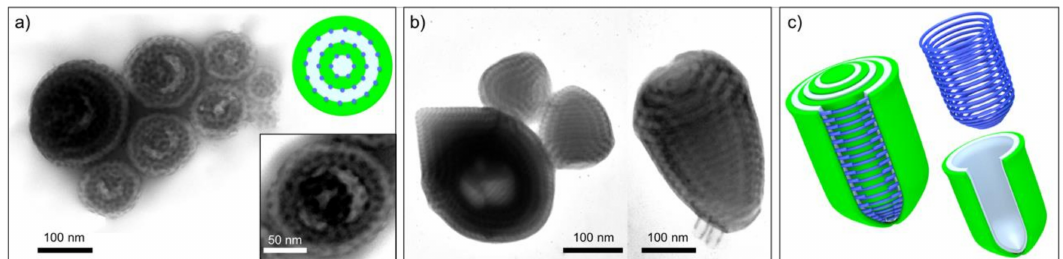
Figure 1. TEM characterization of SVT1 and SVT2. ( a ) Overview image of spherical microparticles of SVT1 with ls morphology. The inset shows a close-up on one particle and a schematic explaining the distribution of phases. ( b ) TEM images of conic SVT2 with lc morphology. ( c ) The schematic shows the distribution of phases; the microparticle consists of PT/PS lamellae (green and grey) intercalated with the hexagonal packing of P4VP rings (blue). (Color code in TEM image: PS grey, P4VP dark grey due to iodine